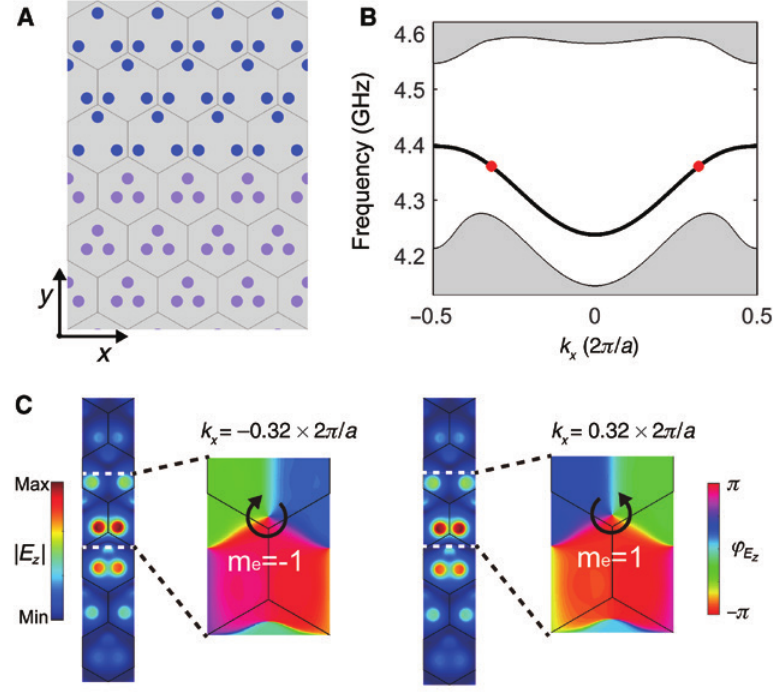
Figure 3: Topologically protected edge states in the Kagome PC. (A) Top view of the edge formed by the PC with Δ R = 1.5 mm (blue) and −1.5 mm (purple). (B) Band dispersion of the edge states, where two = ± 0.32 × 2 π / a . The gray region shades the other red dots highlight the representative edge states with the frequency of 4.36 GHz at k x ϕ of the edge states at k = −0.32 × 2 π / a (left) and k = 0.32 × 2 π / a (right). The black arrow indicates the direction of modes. (C) | E | and z x x z E phase